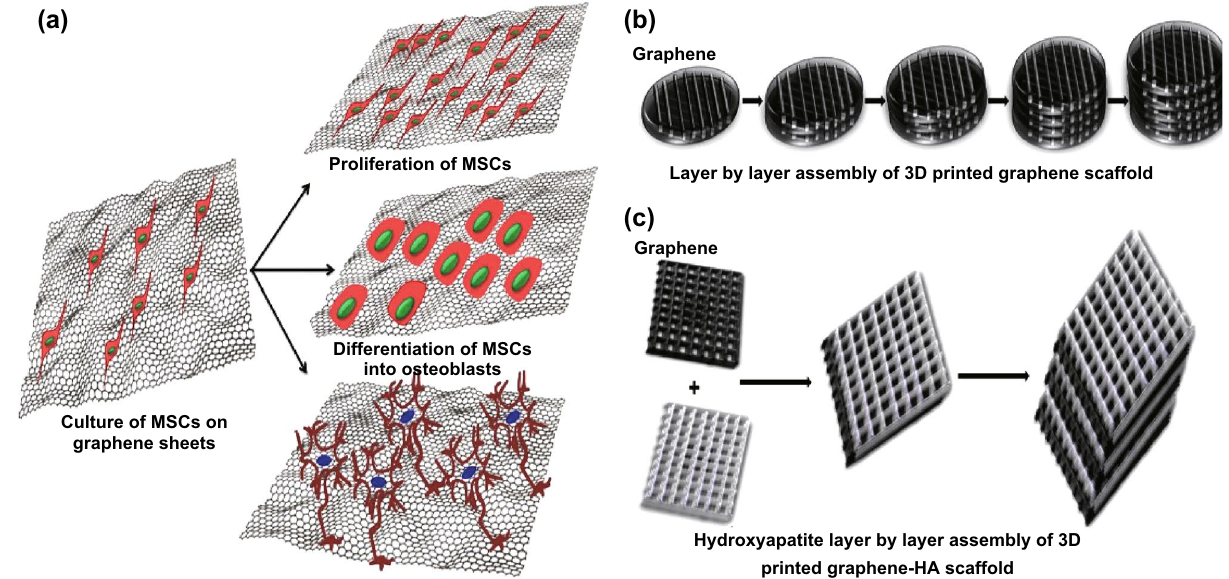
Fig. 6 Graphene as a scaffold for tissue engineering. a The figure explains that graphene enhances the viability and proliferation of mesenchy- mal stem cells and also induces their differentiation toward osteogenesis and neuronal cells without the addition of any differentiation factors. b Layer-by-layer assembly of graphene sheets printed using a 3D printer. c Three-dimensional printing and layer-by-layer assembly of a graphene- HA